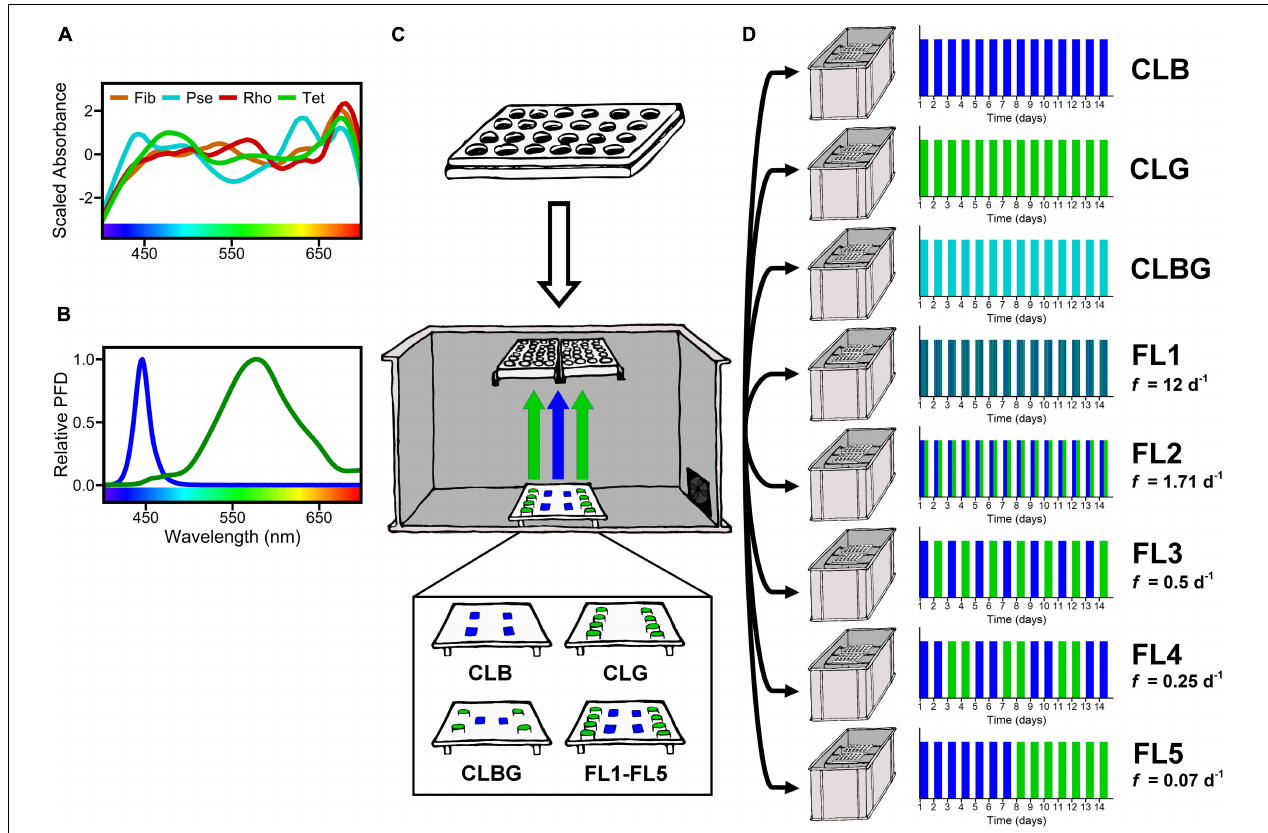
FIGURE 1 | Scheme of experimental setup. (A) Species absorption spectra scaled by z-transformation and (B) the supplied light spectra in relative photon flux density (PFD). The supplied light was adjusted to 50 µ mol photons m – 2 s – 1 integrated over the PAR range for each treatment. (C) Experimental setup by placing two culture microwell plates above the LED array in combinations according to the treatments. Uniformly distribution of LEDs, sufficient distance and a reflective coating of the boxes’ walls and lid ensured a homogenous light distribution for all positions. Temperature control was implied by the opening at the right side of the opaque box. (D) Treatments time schedule stating the fluctuation frequency (f) for an example duration of 14 days. Treatments were considered as “constant” (CLB, CLG, CLBG) if the applied spectrum did not alternate and “fluctuating” if the spectrum alternated (between blue and green) throughout the experiment. They were conducted in replicates of 6 for monocultures and 4 for pairwise species mixtures for each treatment and box,